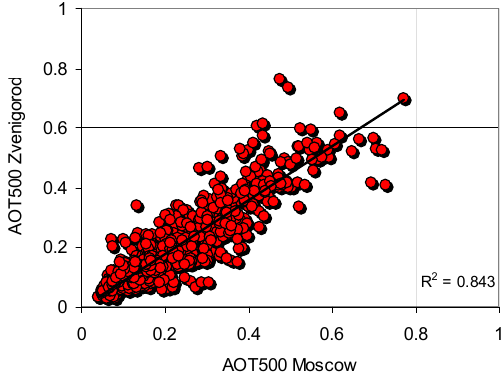
Fig. 1. Comparison between the monthly mean differences in Fig.1. Comparison between the monthly mean differences in AOT500 obtained by the standard AOT500 obtained by the standard M1 and by the proposed M2 M1 and by the proposed M2 methods. See the details in the text. methods. See the details in the text.